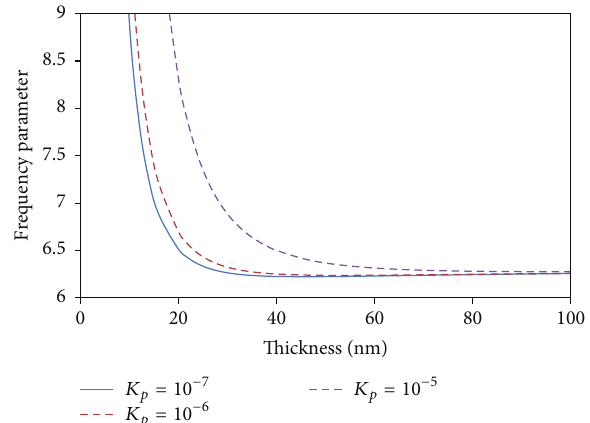
Figure 10: Dimensionless natural frequency with respect to thick- ness ℎ for various Pasternak elastic foundations (𝐾 𝑤 = 10 10 , 𝑅 = 30 nm , Δ𝑇 = 100, 𝜇 = 1, 𝑏 = 50 nm , 𝜃 = 𝜋/2) .